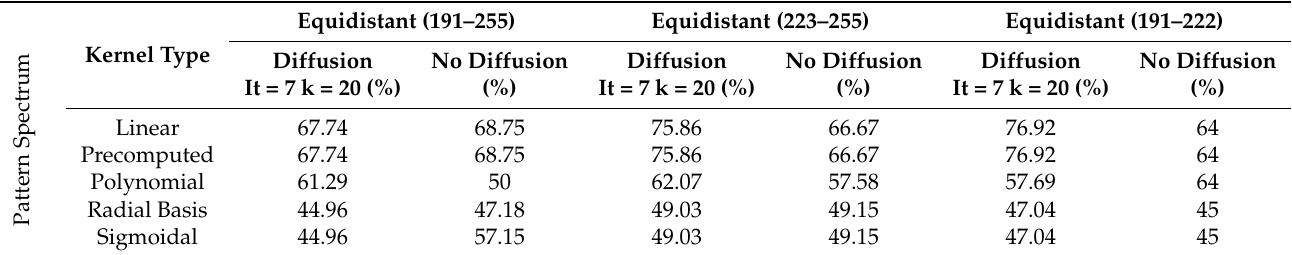
Table 1. Drunk person identification results for the three isothermal regions and feature vector the pattern spectrum for various kernel types. The best performance is obtained for isotherms (223–255) and (191–222) with